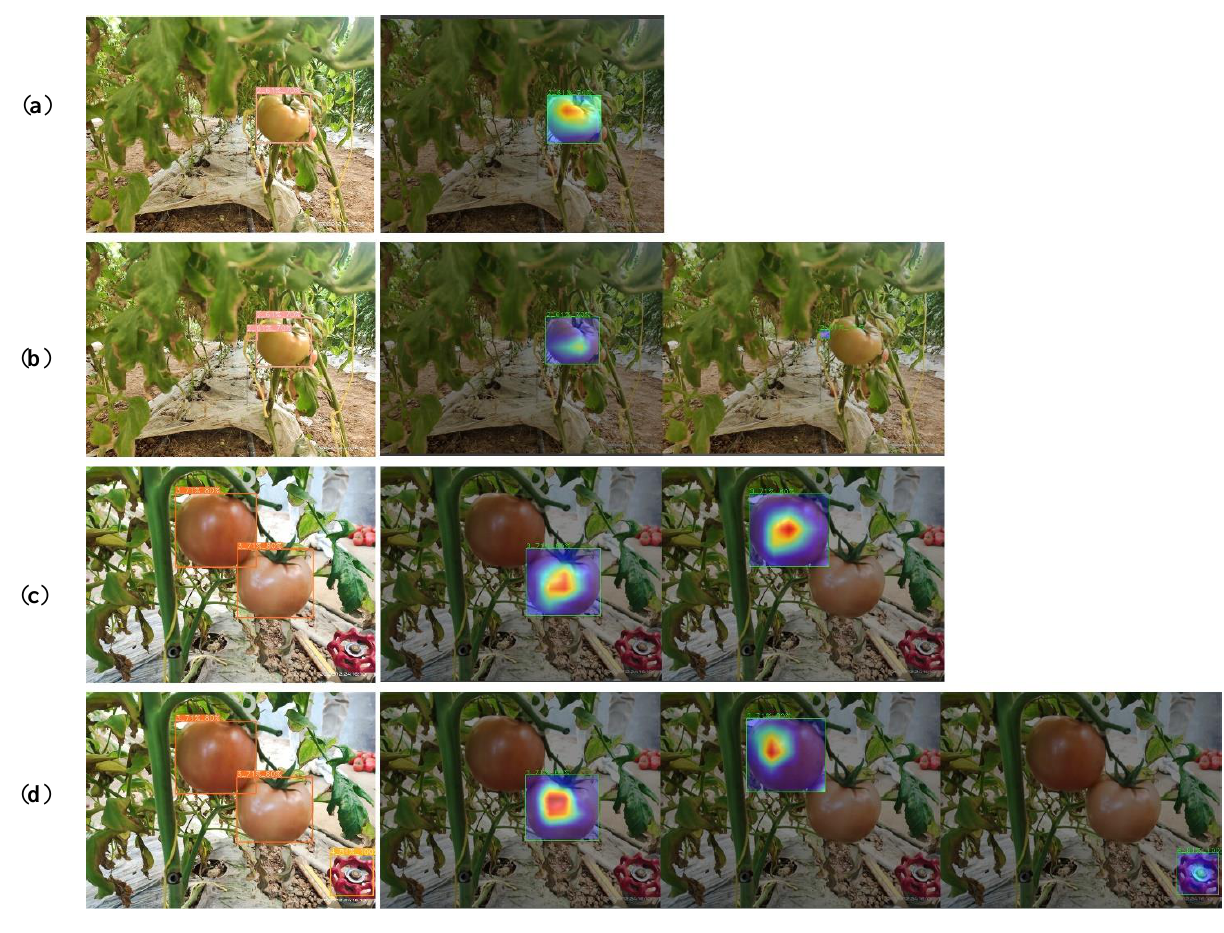
Figure 10. Grad-CAM visualization. ( a ) SE-YOLOv3-MobileNetV1; ( b ) YOLOv3-MobileNetV1; ( c ) SE-YOLOv3-MobileNetV1; ( d ) YOLOv3-MobileNetV1.